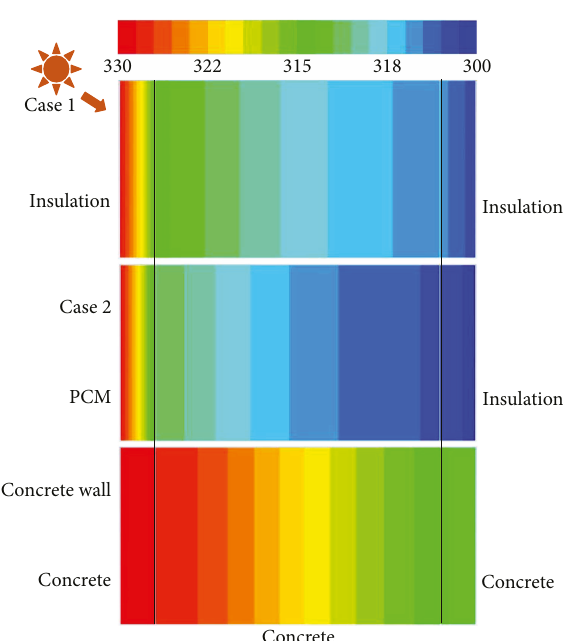
Figure 5: Temperature variation and heat fl ux of the inside wall under di ff erent cases.